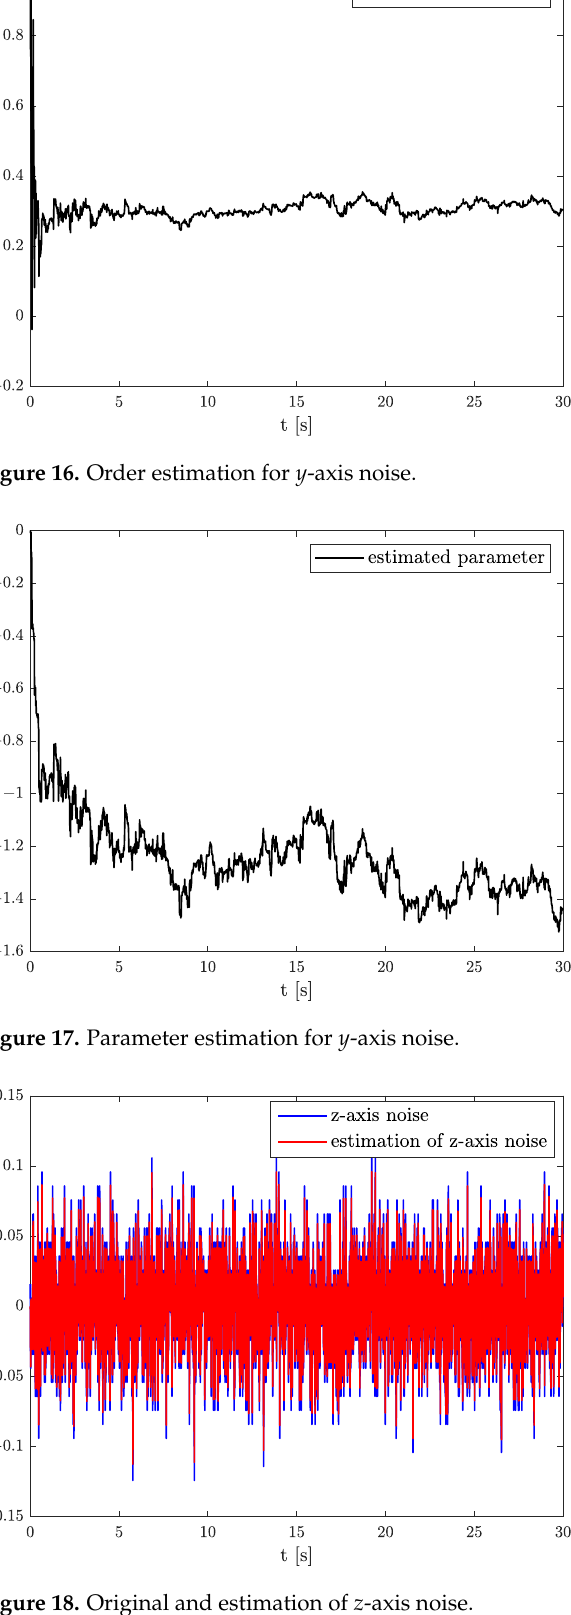
Figure 18. Original and estimation of z -axis